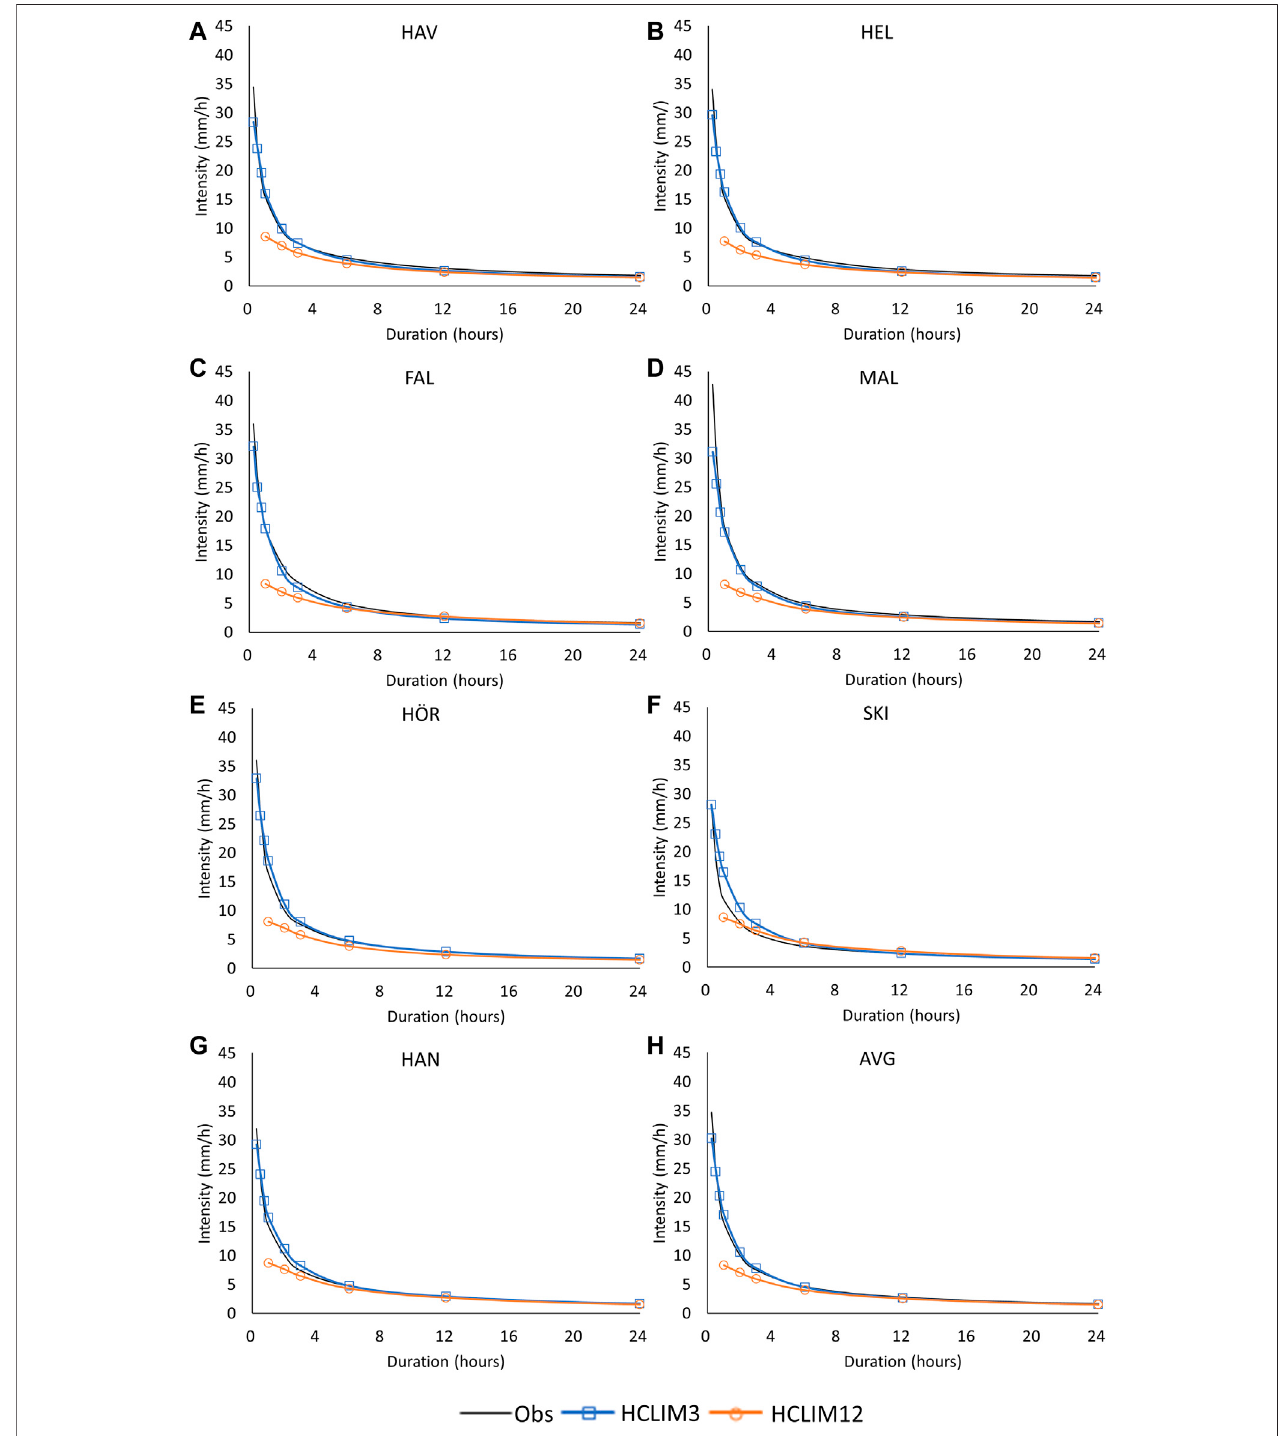
FIGURE6| Intensity-DurationcurvesofobservedandsimulatedaverageannualmaximainstationsHAV (A) ,HEL (B) ,FAL (C) ,MAL (D) ,HÖR (E) ,SKI (F) andHAN (G) as well as on average over all stations (H) .